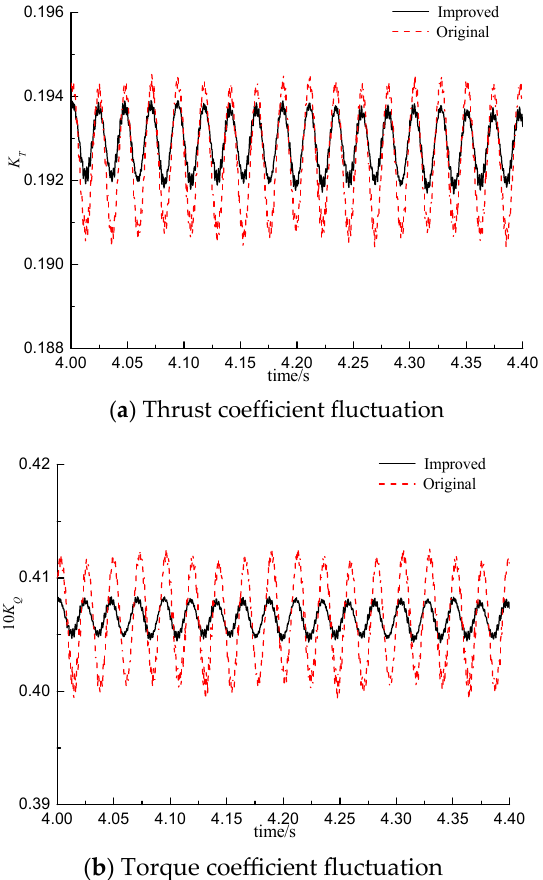
Figure 12. Time–domain fl uctuation curves of propeller loads.